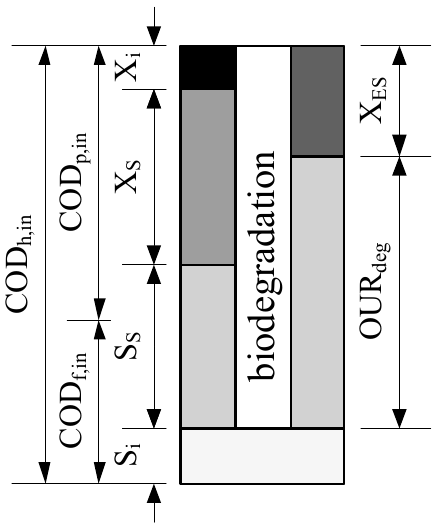
Figure 3. Chemical oxygen demand (COD) fractions during biological treatment [20].